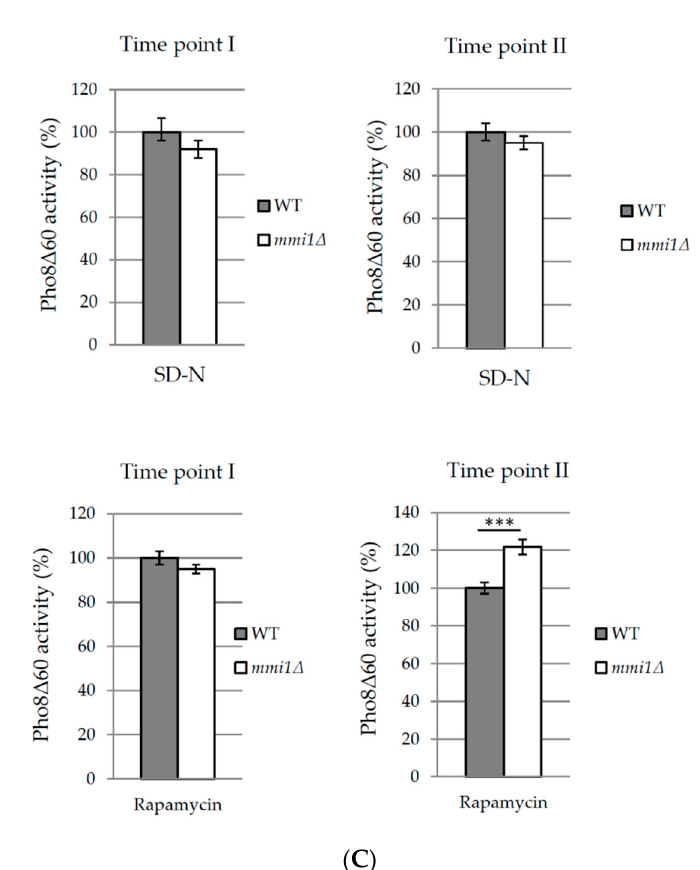
Figure 5. Increased rapamycin-induced autophagy in mmi1 Δ strain occurs after glucose exhaustion. ( A ) Exponentially growing WT and mmi1 ∆ cells expressing Pho8 Δ 60 (OD 600 ≈ 0.8) in the YPD medium were either shifted to the SD-N medium or treated with rapamycin (200 nM). Optical density at 600 nm was measured at indicated time points. Results are presented as means ± SD of three independent experiments performed in duplicates (n = 6). ( B ) Concentration of glucose in the media as shown in A was measured after the addition of rapamycin (200 nM) to WT and mmi1 ∆ strains or after the shift of the strains to SD-N media. Results are means of two independent experiments performed in triplicates (n = 6). ( C ) Pho8 ∆ 60 assay was measured in time points I and II as indicated in A, and B. Point I represents the exponential growth phase where glucose is still present in the medium. Point II represents the post-diauxic phase where glucose is already exhausted. Results are normalized to the WT strain (100%) and represent means ± SD from two independent experiments performed in duplicates (n = 4). The statistical evaluation was performed by using two way analysis of variance (ANOVA). *** p < 0.001.